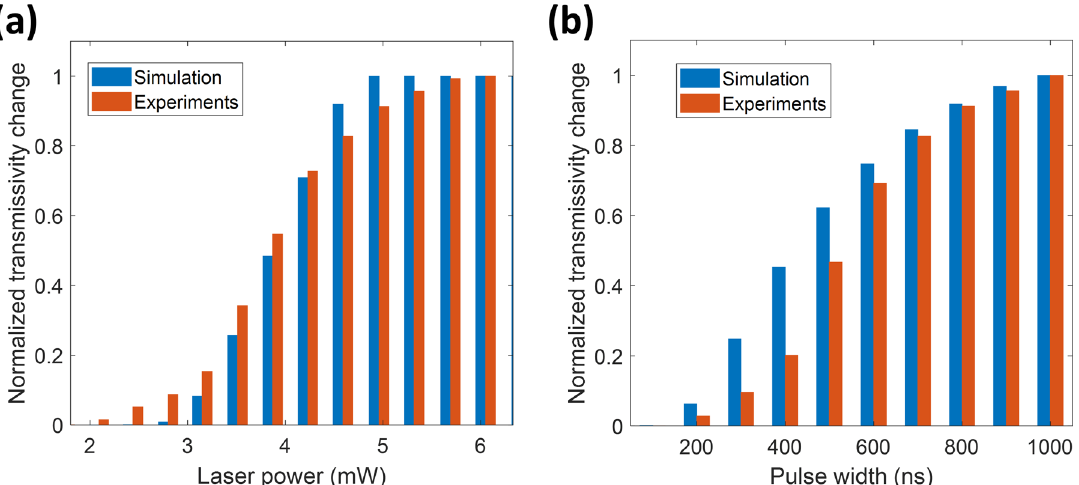
Fig. 6 Multilevel switching performance. a Simulated and measured normalised transmissivity change at 300 ns laser pulses width different laser powers. b Simulated and measured normalised transmissivity change at 3.5 mW laser pulses width different